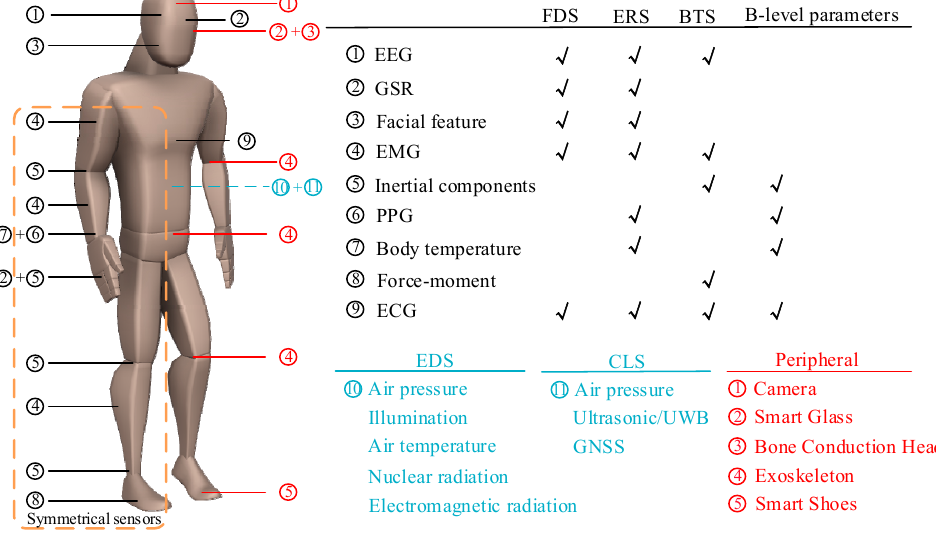
Figure 2. The sensor deployment model based on the multi-level fusion framework (MLFF).